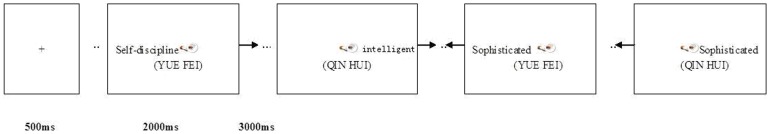
Positive approach - negative avoidance (consistent pattern, audition).The Group 5 condition tested a consistent pattern based on auditory stimuli. The pronunciation of the name of the reference object appeared in the center of the screen, and a corresponding personality adjective appeared at either the left or the right of this pronunciation.